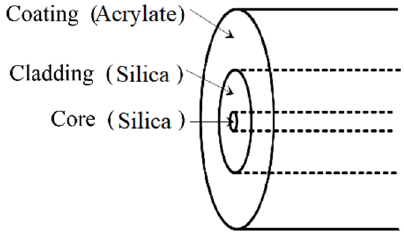
Figure 8. The composition and material of the optical fiber.